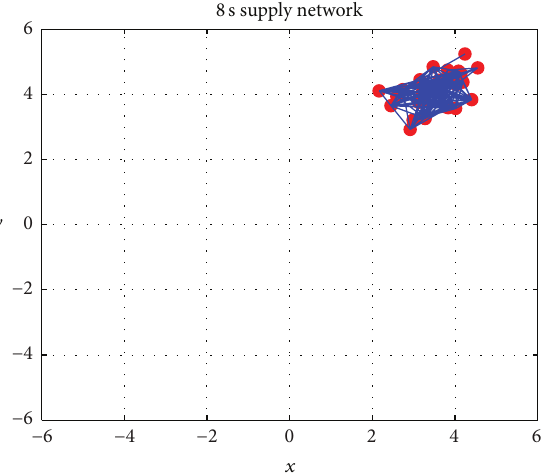
Figure 5: Evolution results of number 2.